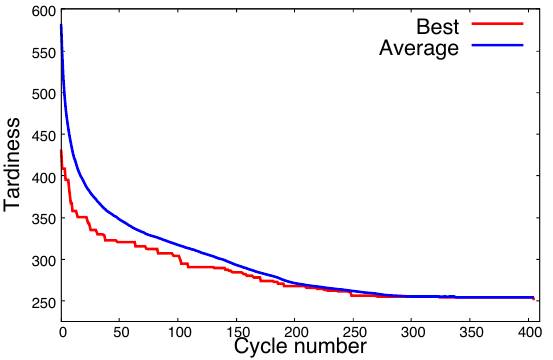
Figure 2. Evolution of the best and average tardiness values along the iterations in one run in an instance of scenario 1, type 1, ∆ = 0.2 and n = 20, considering the static version of the